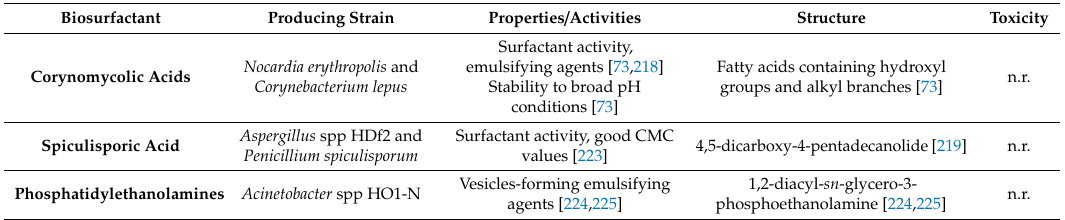
Table 3. Fatty acid, phospholipid, and neutral lipids biosurfactants. N.r. = not